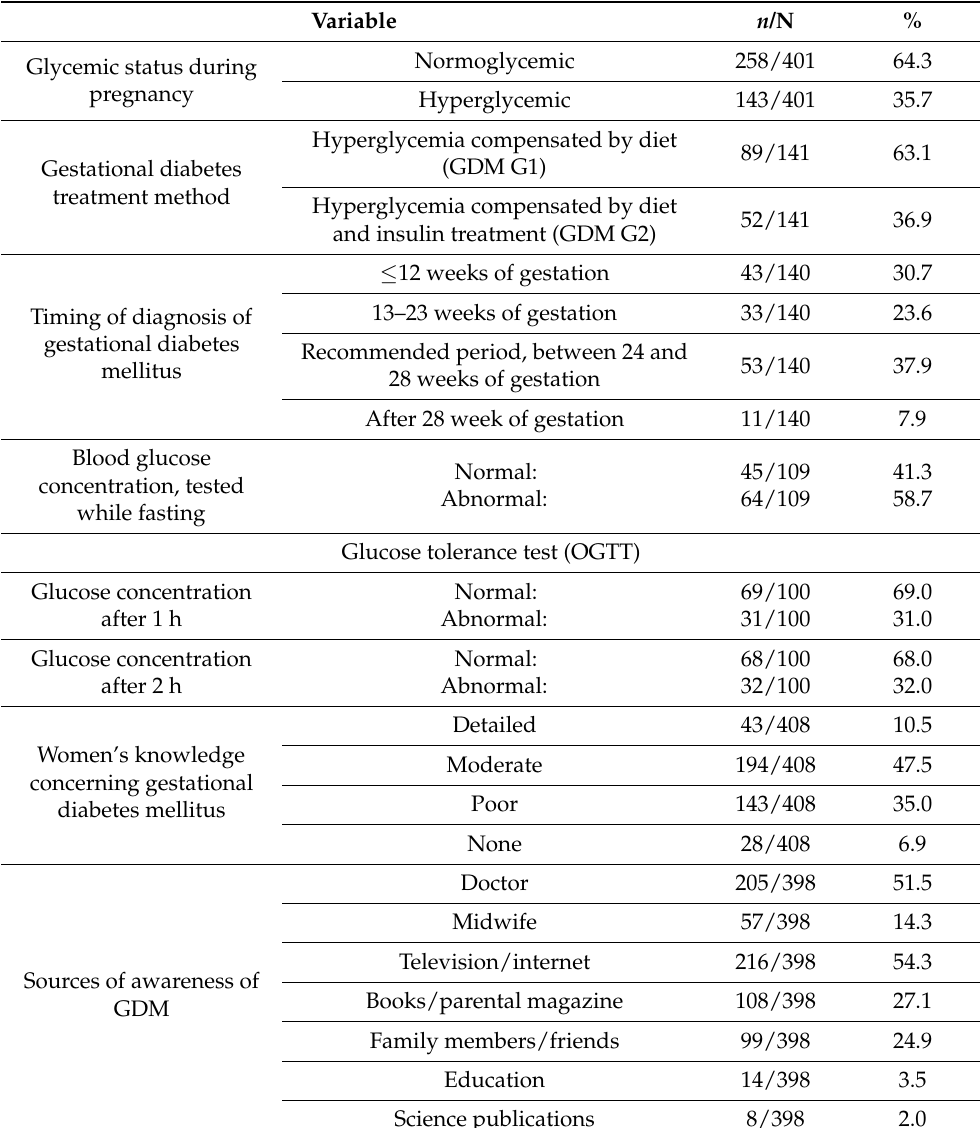
Table 5. Characterization of glycemic status of the analyzed cohort of